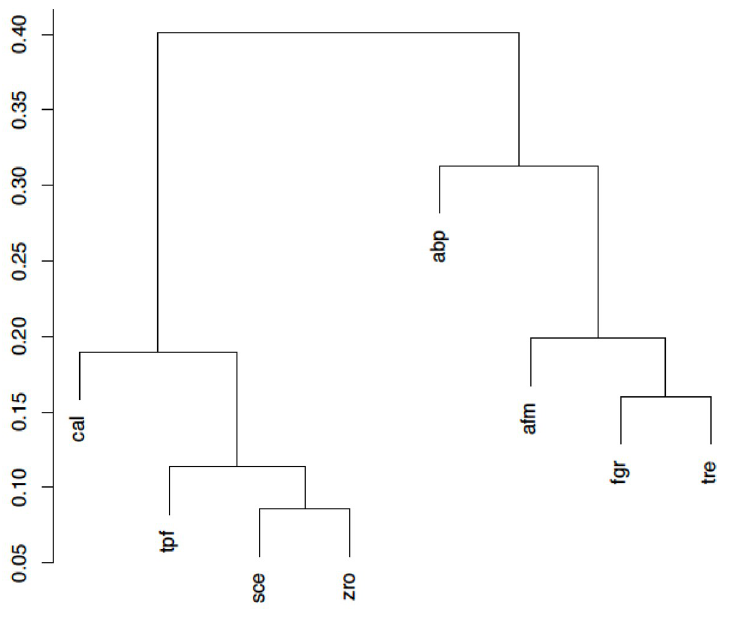
Fig 6. Clustering obtained in the Yeasts and Molds experiment for the pathway similarity